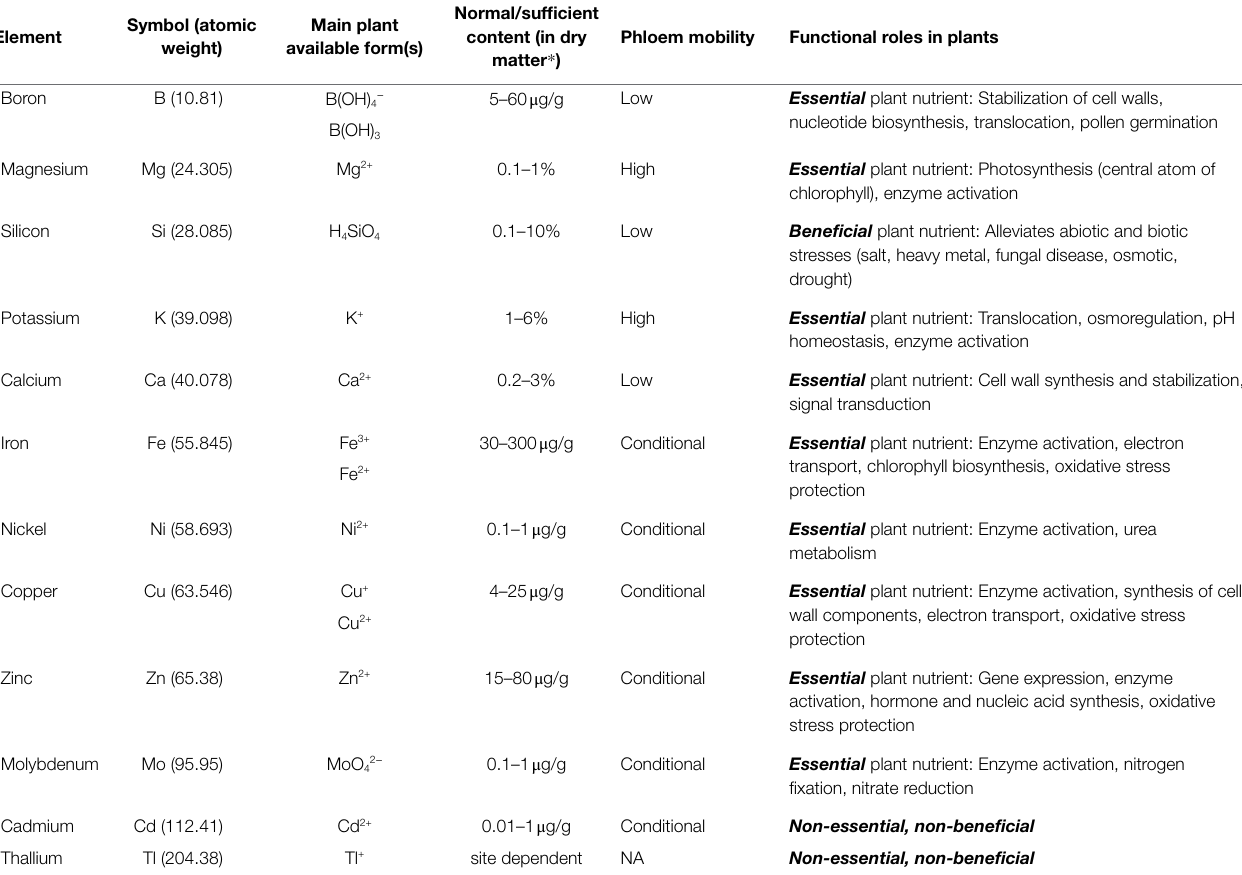
TABLE 2 | Overview of elements found in plant tissue that have been studied using stable isotope fractionation (listed according to atomic weight)**.